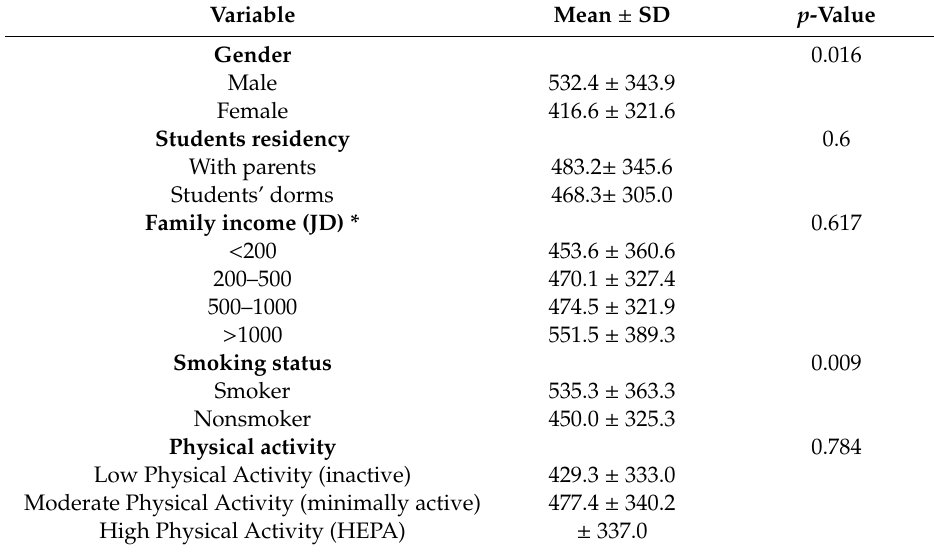
Table 3. Calories from SSBs in relation to students’ characteristics.